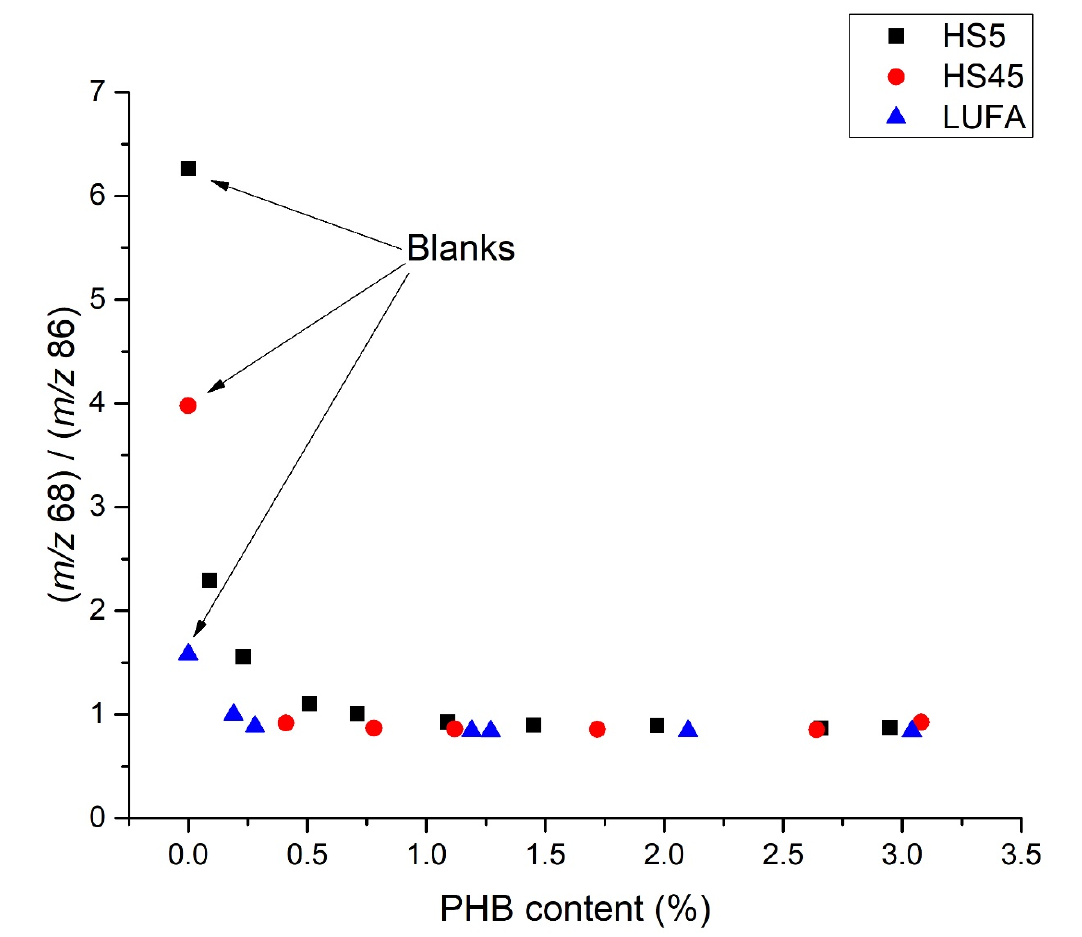
Figure 7. Ratios of PHB peaks of ions with m / z 68 and 86 in different soils as a function of MBP concentration.